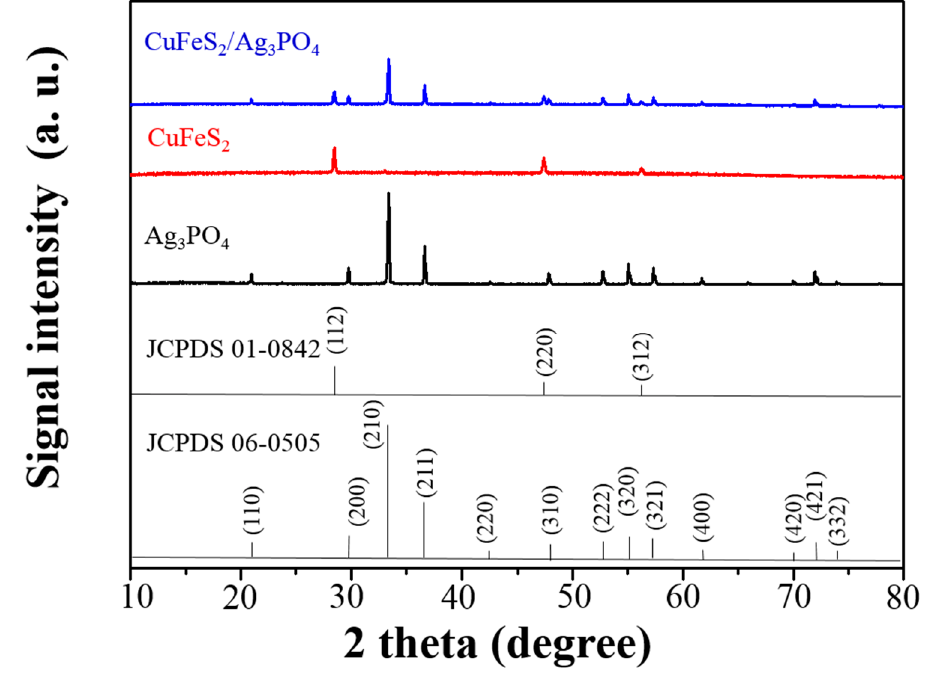
Figure 3. XRD patterns of different samples: Ag 3 PO 4 (black); CuFeS 2 (red); and CuFeS 2 /Ag 3 PO 4 composites (blue).